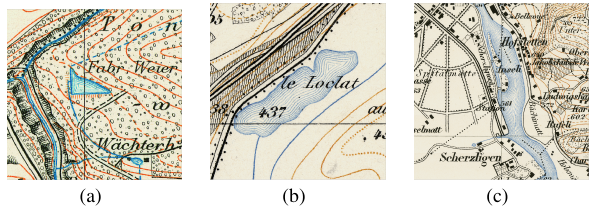
Figure 7. Examples of similar symbolization between rivers (c) and lakes (a)